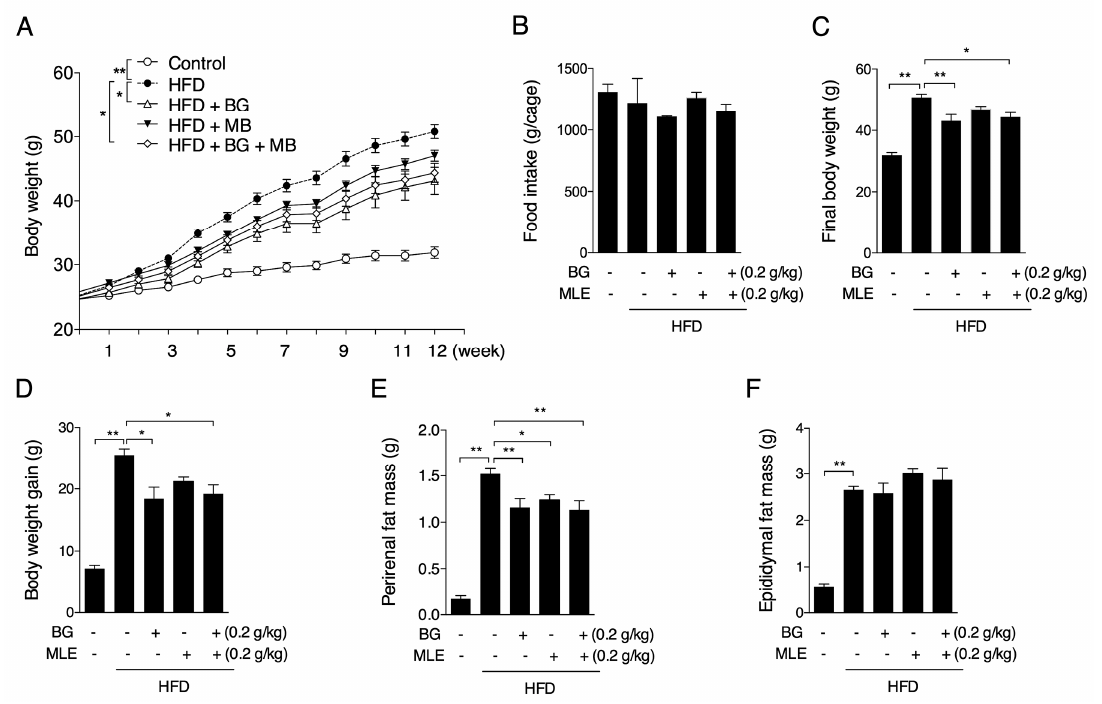
Figure 1. Effects of BG and MLE on body and tissue weights. Body weight curve ( A ); final body weight ( B ); body weight gain ( C ); perirenal fat mass ( D ); and epidydimal fat mass ( E ) in male C57BL/6 mice fed a control diet or a high-fat diet supplemented with BG or/and MLE for 12 weeks. The data are the mean ± SEM, n = 10. * p < 0.05, ** p < 0.01 vs. related control. BG: beta-Glucan; MLE: mulberry leaf extract; HFD: high-fat diet.